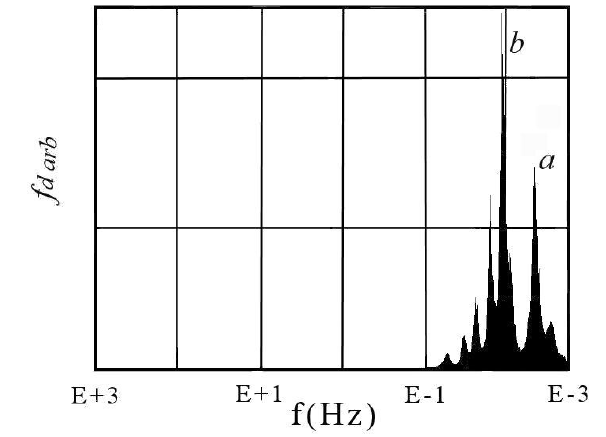
Figure 21. Power spectra and dominant frequency for Warburg impedance between equilibrium and reversible potential. a: 5 × 10 − 3 Hz, b: 2 × 10 − 2